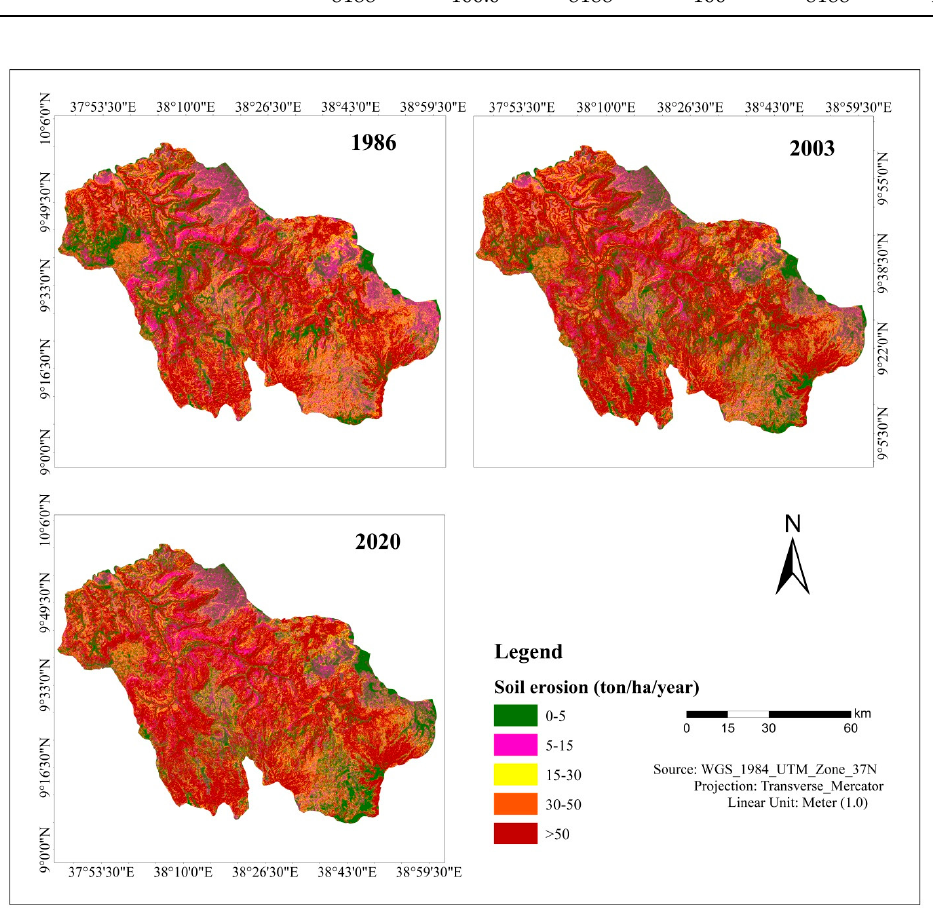
Figure 10. Muger Sub-basin spatial distribution of soil loss in 1986, 2003, and 2020.